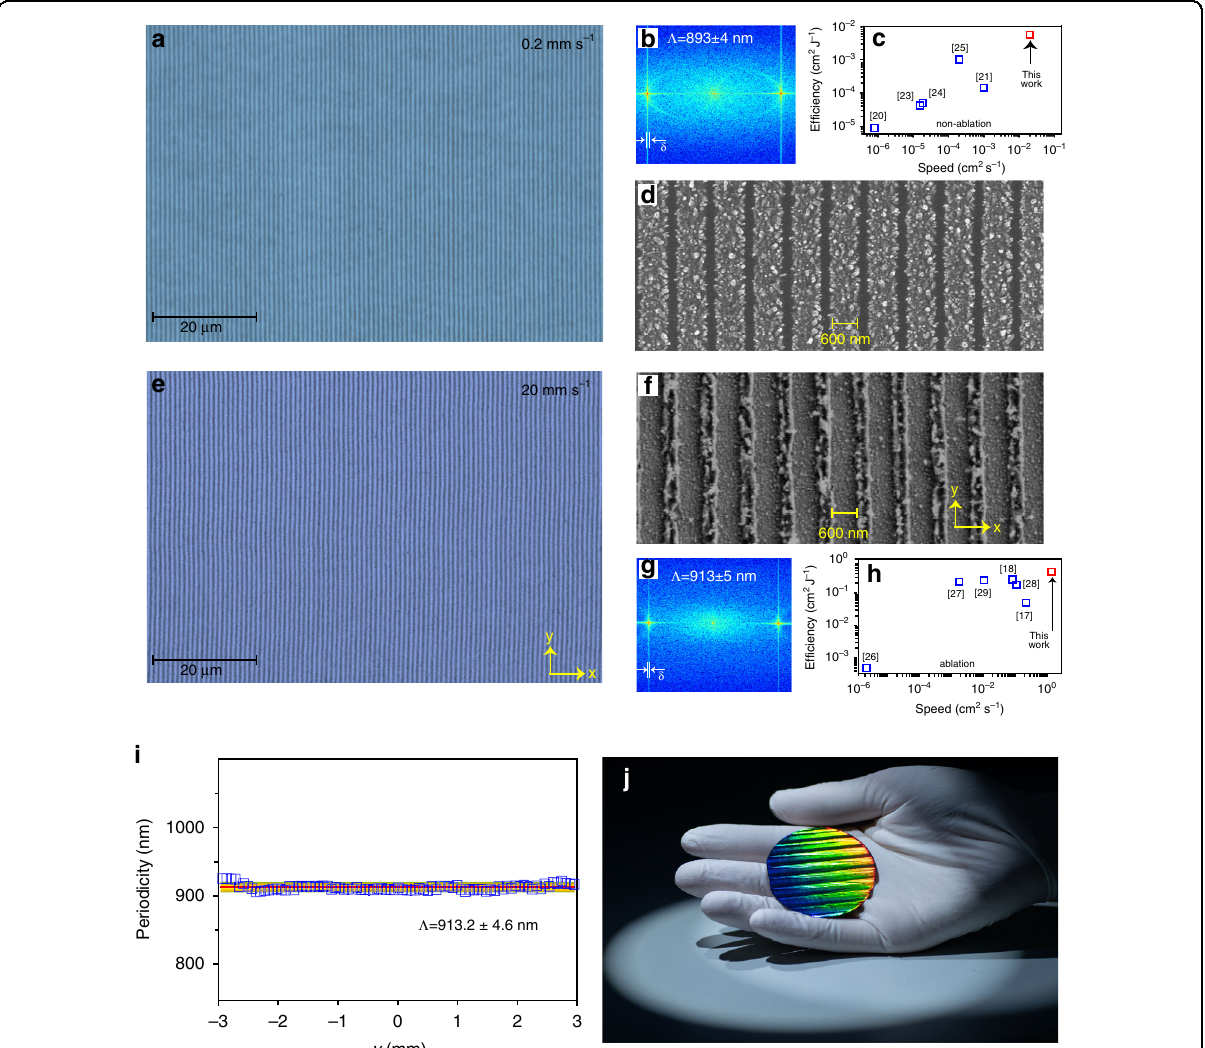
Fig. 2 Characterization of femtosecond laser-written nanogratings. Microscopy images of nanogratings that are fabricated with a scanning speed of v s = 0.2 mm s − 1 ( a ) and v s = 20 mm s − 1 ( e ). Their 2D Fourier transforms and high-resolution images are displayed in b , d and f , g , respectively. δ denotes standard deviation of the periodicity. At low scanning speed, the nanogratings are self-organized via oxidation, while at high speed, they are produced through ablation. Comparison of manufacturing speeds and energy ef fi ciency of our works with other high-speed manufacturing of nanogratings in terms of non-ablation processes ( c ) including oxidation in refs. 20,23,24 , reduction in ref. 21 , and phase change in ref. 25 or ablation ( h ). Please note that ref. 29 employed the scanning beam interference lithography. i Periodicity of ablative nanogratings along y - direction. Here y = 0 denotes the center of laser spot. The ablative trace along y -direction is 6 mm, shorter than the oxidized trace of 10 mm. j photograph of a 2-inch single-crystalline Si wafer coated with 100 nm of Ag and 50 nm of amorphous Si. The vivid rainbow color of the wafer indicates the existence of highly regular nanogratings. The wafer-scale nanogratings were produced within 20